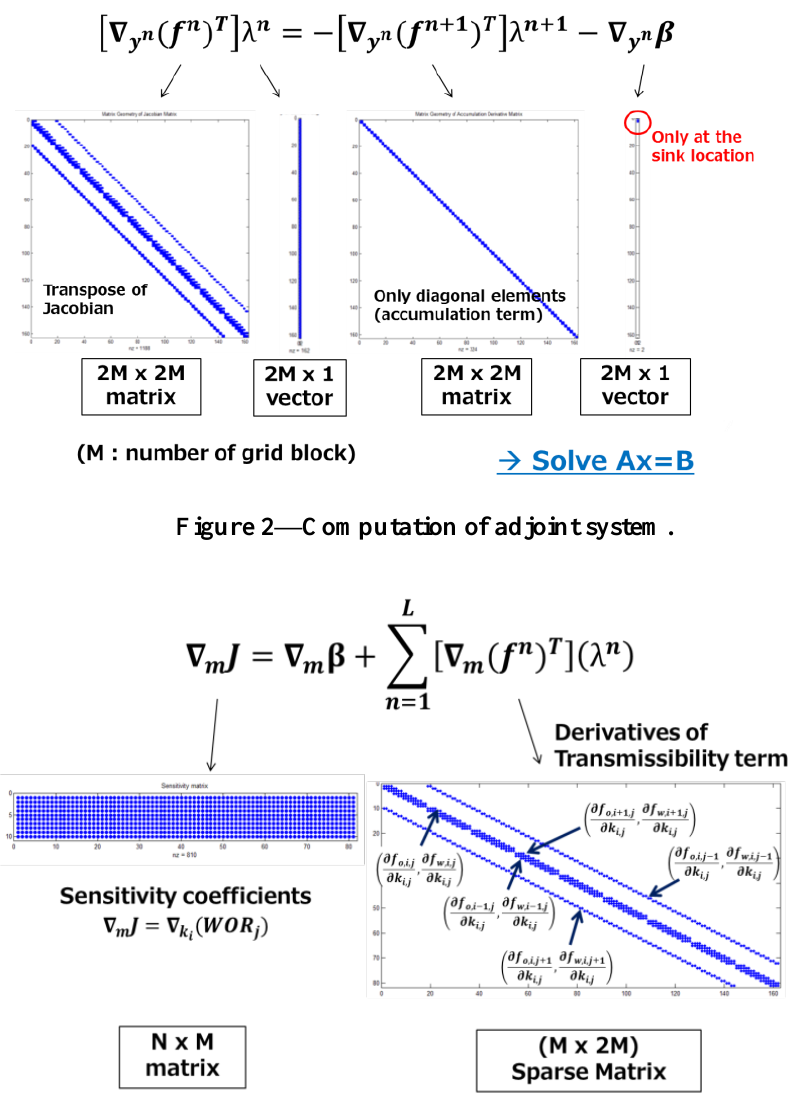
Figure 3—Computation of Sensitivity